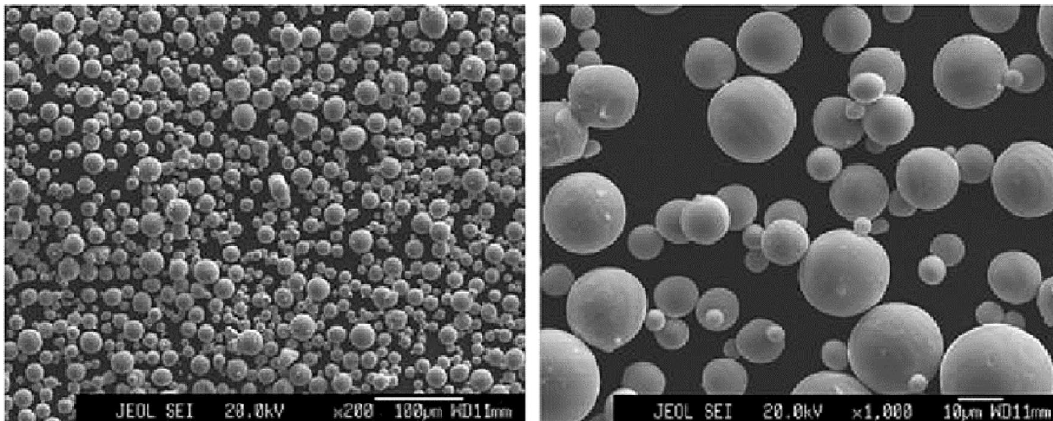
Figure 3. Microstructure of 316L alloy powder.